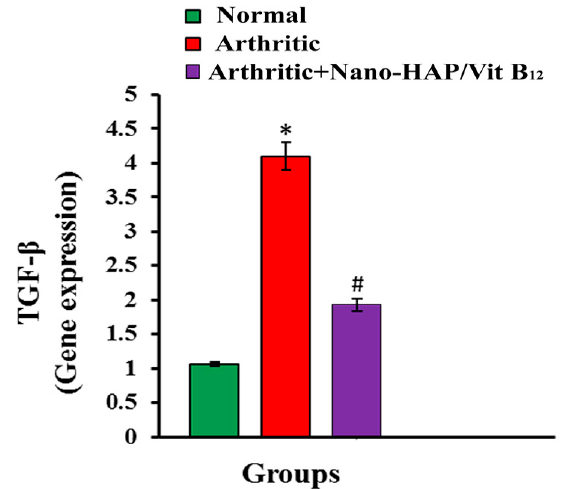
Figure 8. E ff ect of nano-HAP/Vit B 12 on TGF- β mRNA expression (Data are expressed as mean val- values ± SEM, (* p < 0.05: significant difference relative to arthritic rats, # p < 0.05: significant ues ± SEM, (* p < 0.05: signi fi cant di ff erence relative to arthritic rats, # p < 0.05: signi fi cant di ff erence difference relative to arthritic rats treated with Nano-HAP/Vit B 12 relative to arthritic rats treated with Nano-HAP/Vit B 12 ).